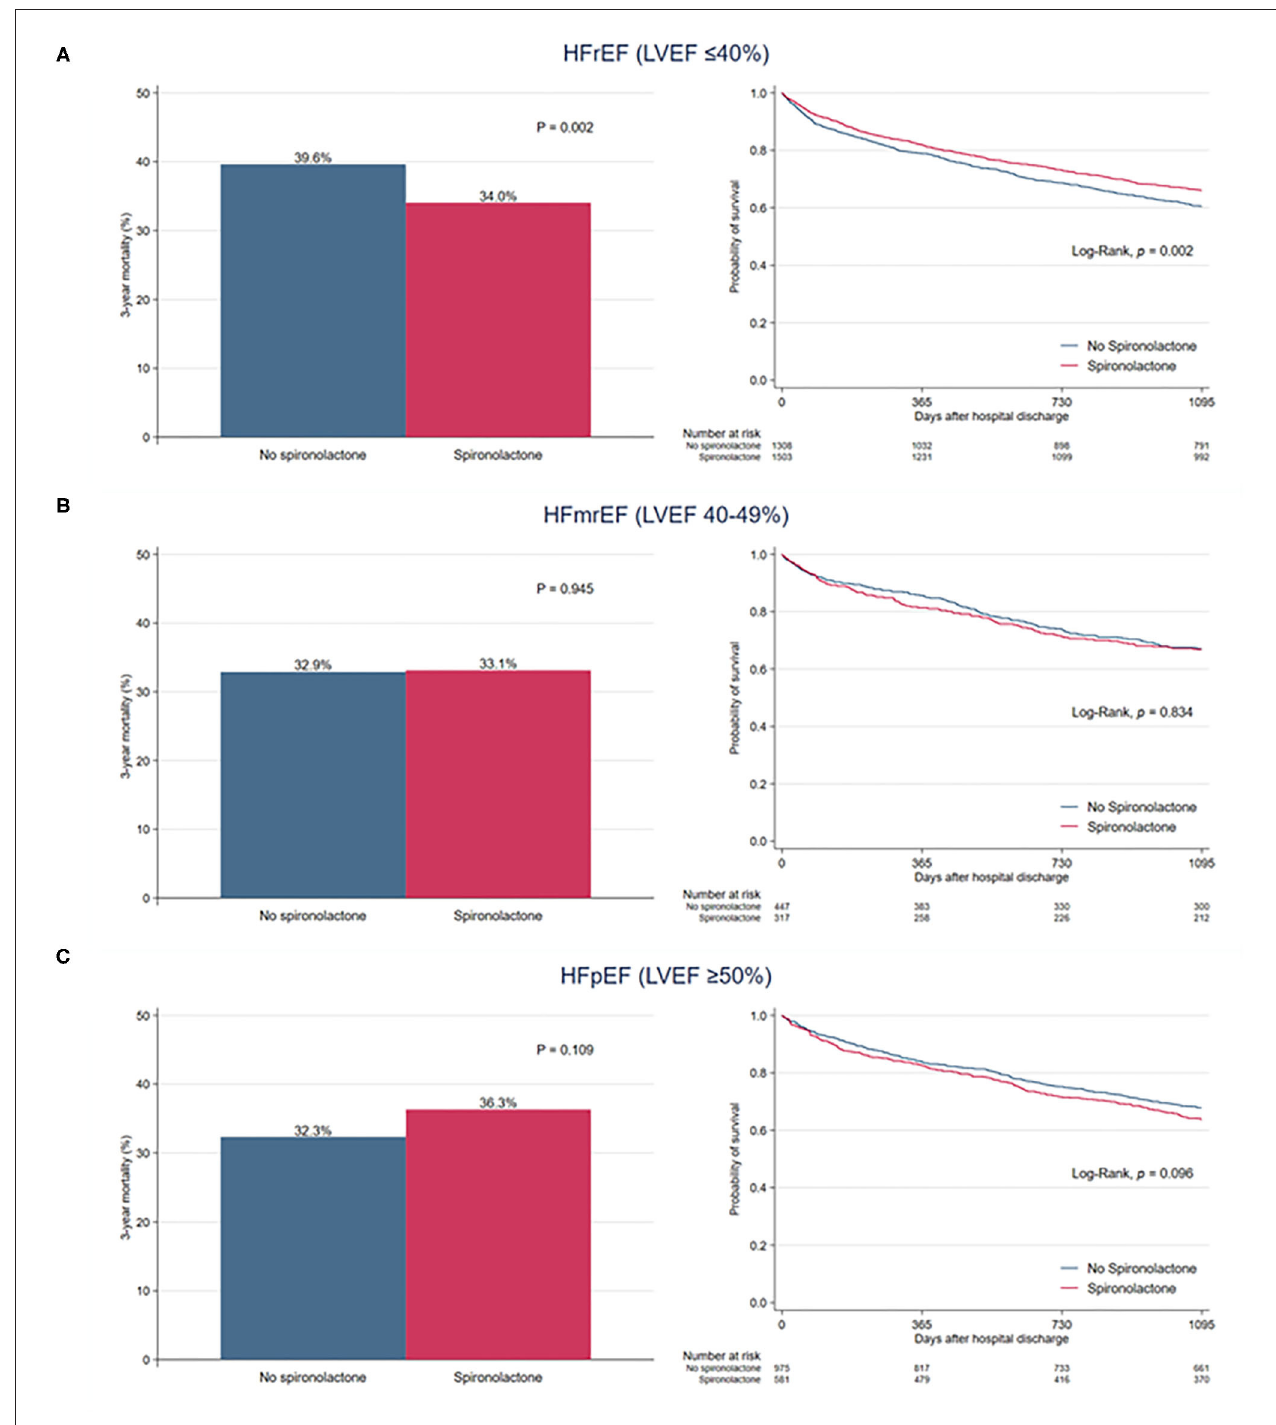
FIGURE 4 | Bar graph and Kaplan–Meier curves of the 3-year all-cause mortality after hospital discharge according to spironolactone treatment in patients with (A) heart failure with reduced ejection fraction (HFrEF), (B) heart failure with mid-range ejection fraction (HFmrEF), and (C) heart failure with preserved ejection fraction